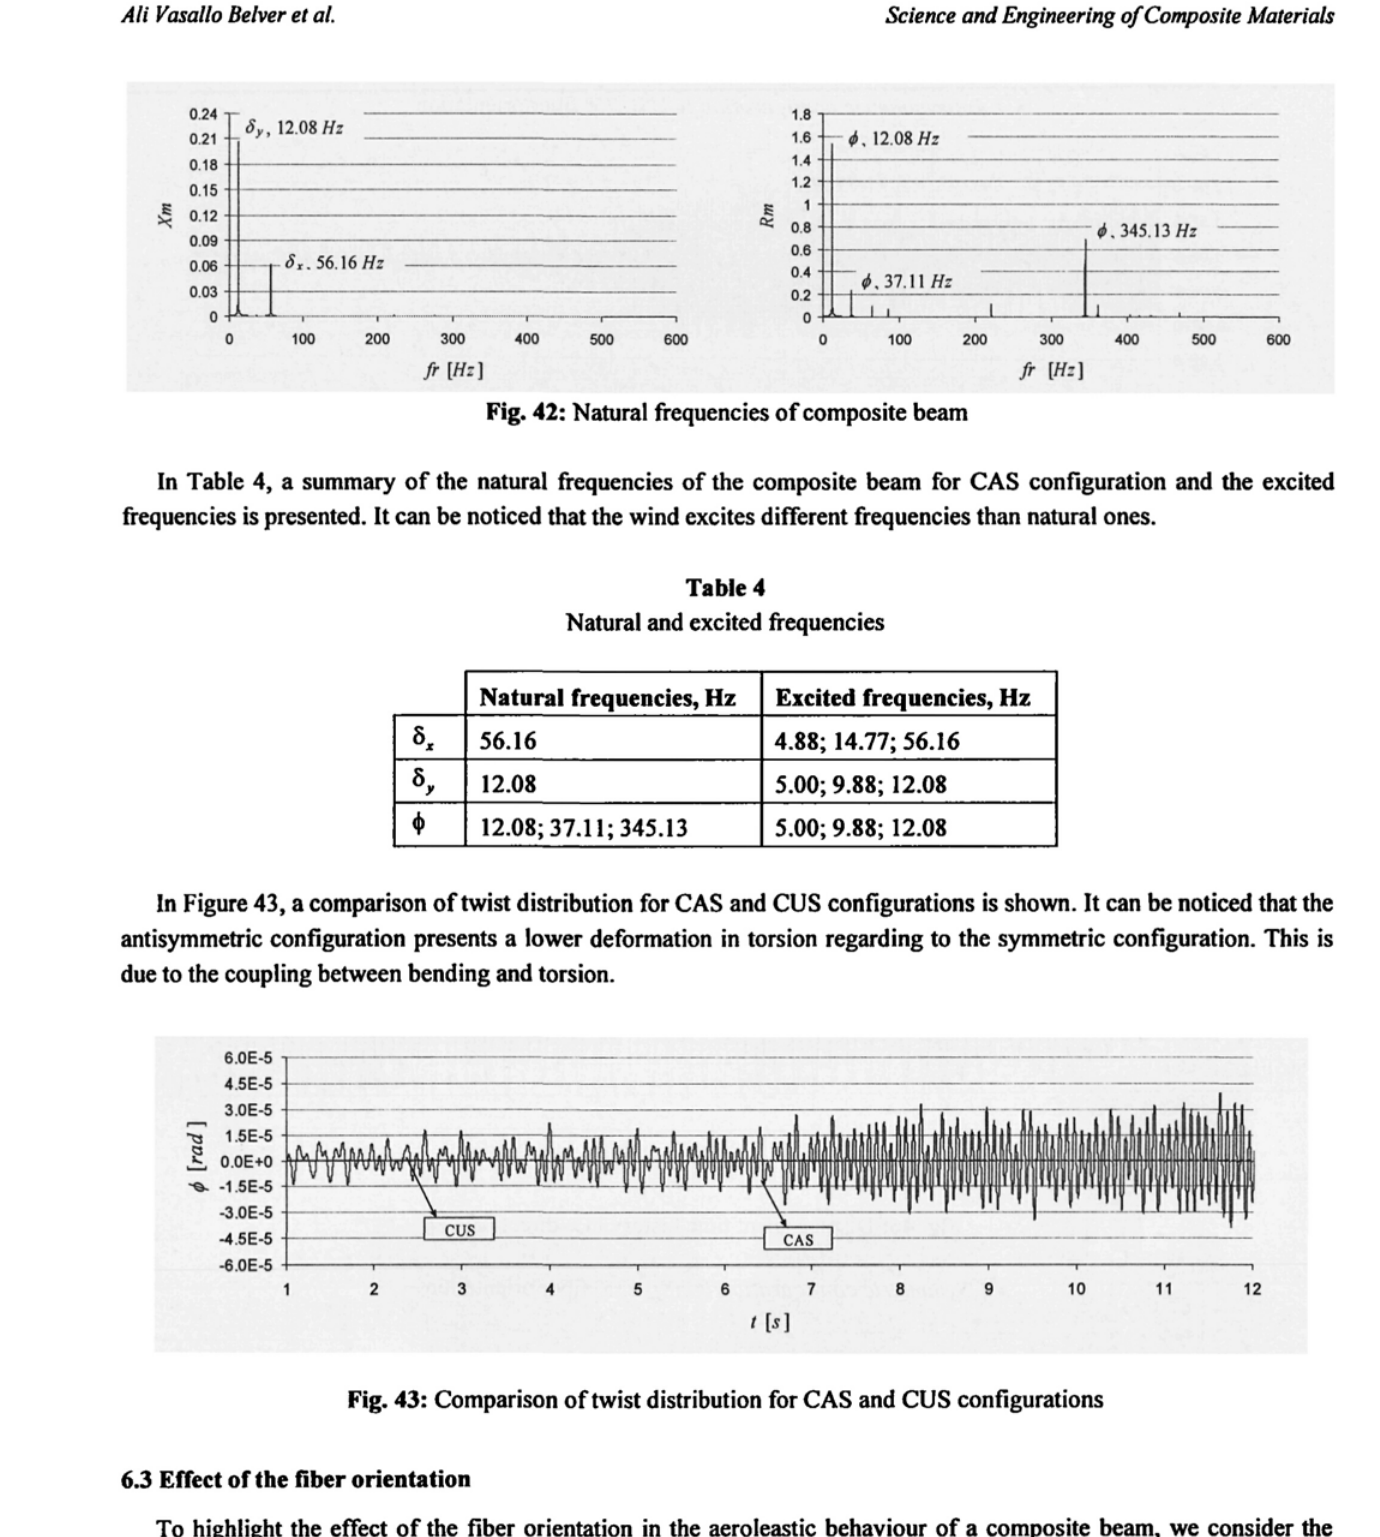
Fig. 43: Comparison of twist distribution for CAS and CDS